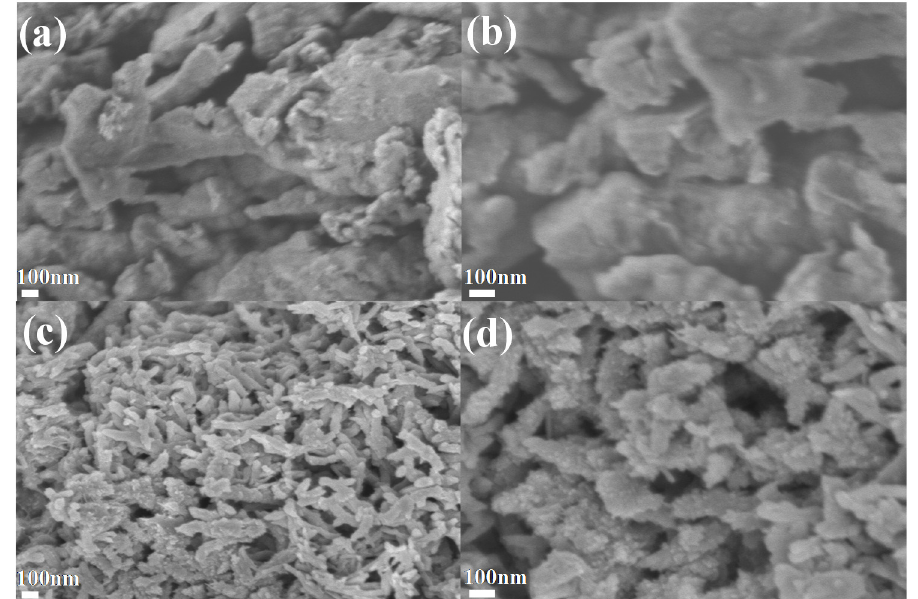
Figure 1. SEM micrographs of g-C 3 N 4 ( a , b ) and Pani@g-C 3 N 4 ( c , d ) at different magnifications (( a , c ) is at 30,000× and ( b , d ) is at 60,000× magnification).